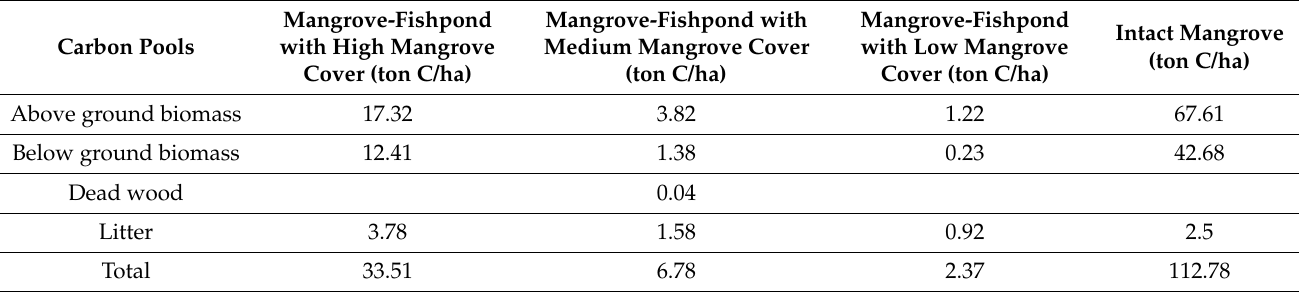
Table 3. Carbon storage in four carbon pools in the study area.